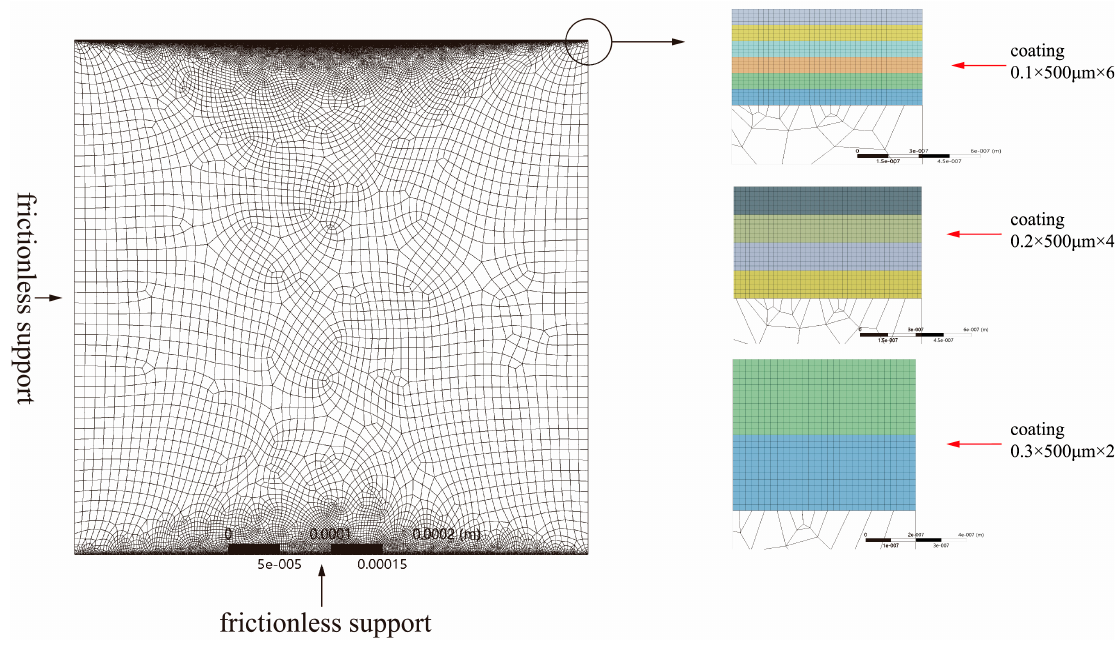
Figure 4. Mesh and boundary condition of the finite